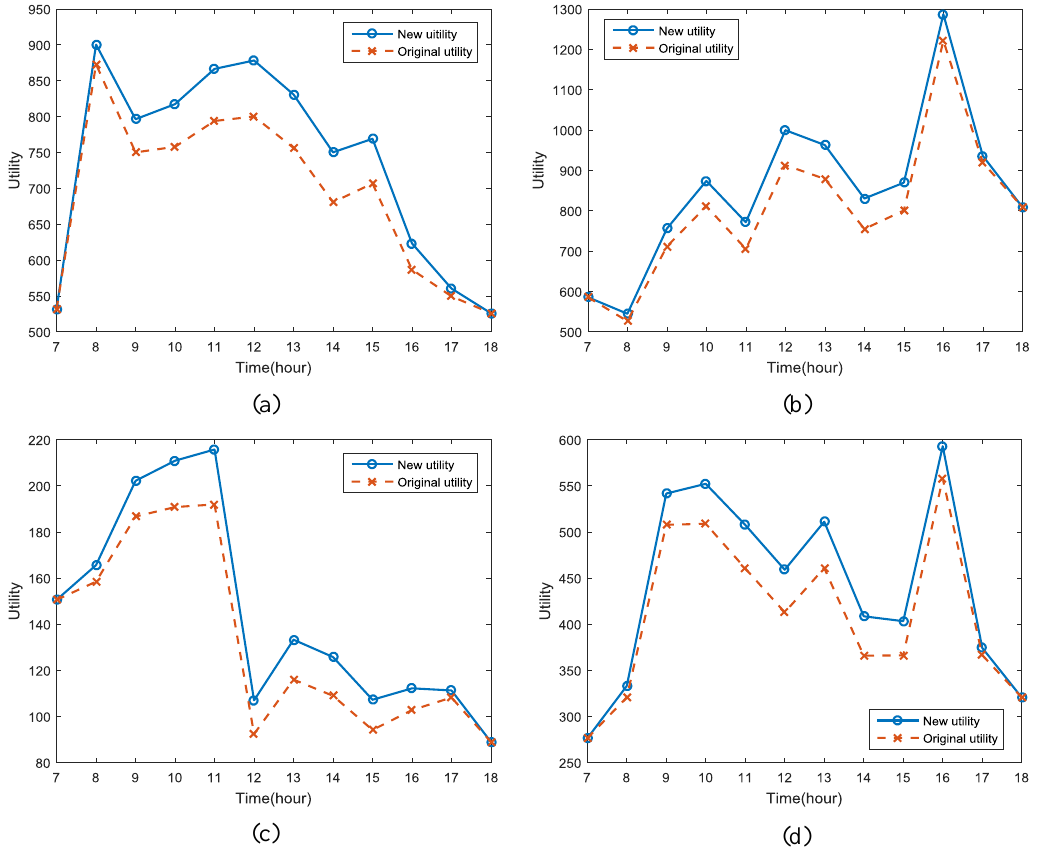
Figure 8. The comparison of the integral utilities of prosumer 1 ( a ); prosumer 2 ( b ); prosumer 3 ( c ) and prosumer 4 ( d ) before and after participating the PVC.